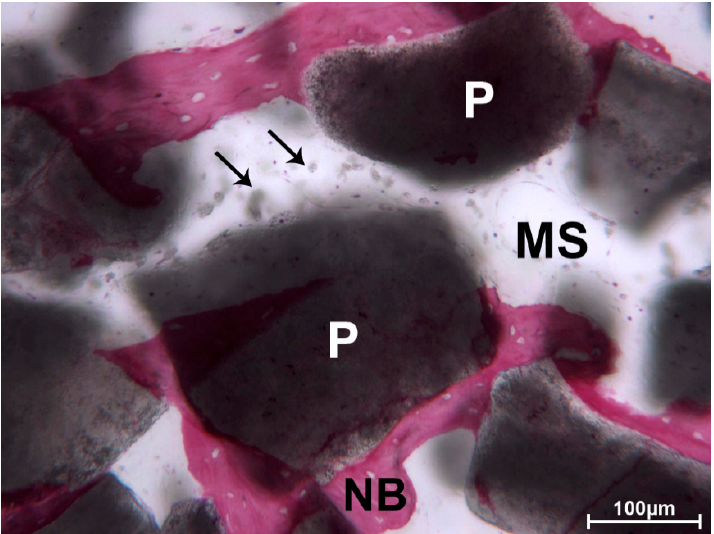
Figure 7. AAB. Large particles of AAB (P) with blurred margins, partially lined by newly formed bone (NB), and small spots of biomaterial (black arrows) colonized the marrow spaces (MS). Toluidine blue and acid fuchsin, original magnification 100×.